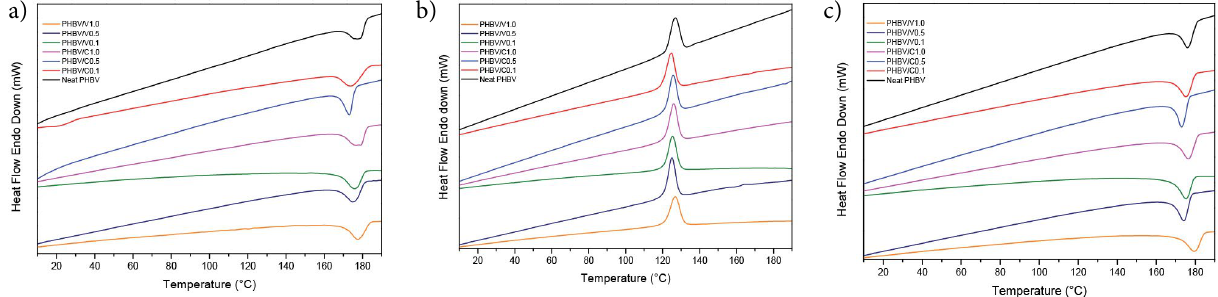
Figure 8. DSC thermograms of polymer composites from the (a) first heating scan, (b) cooling scan, and (c) second heating scan.